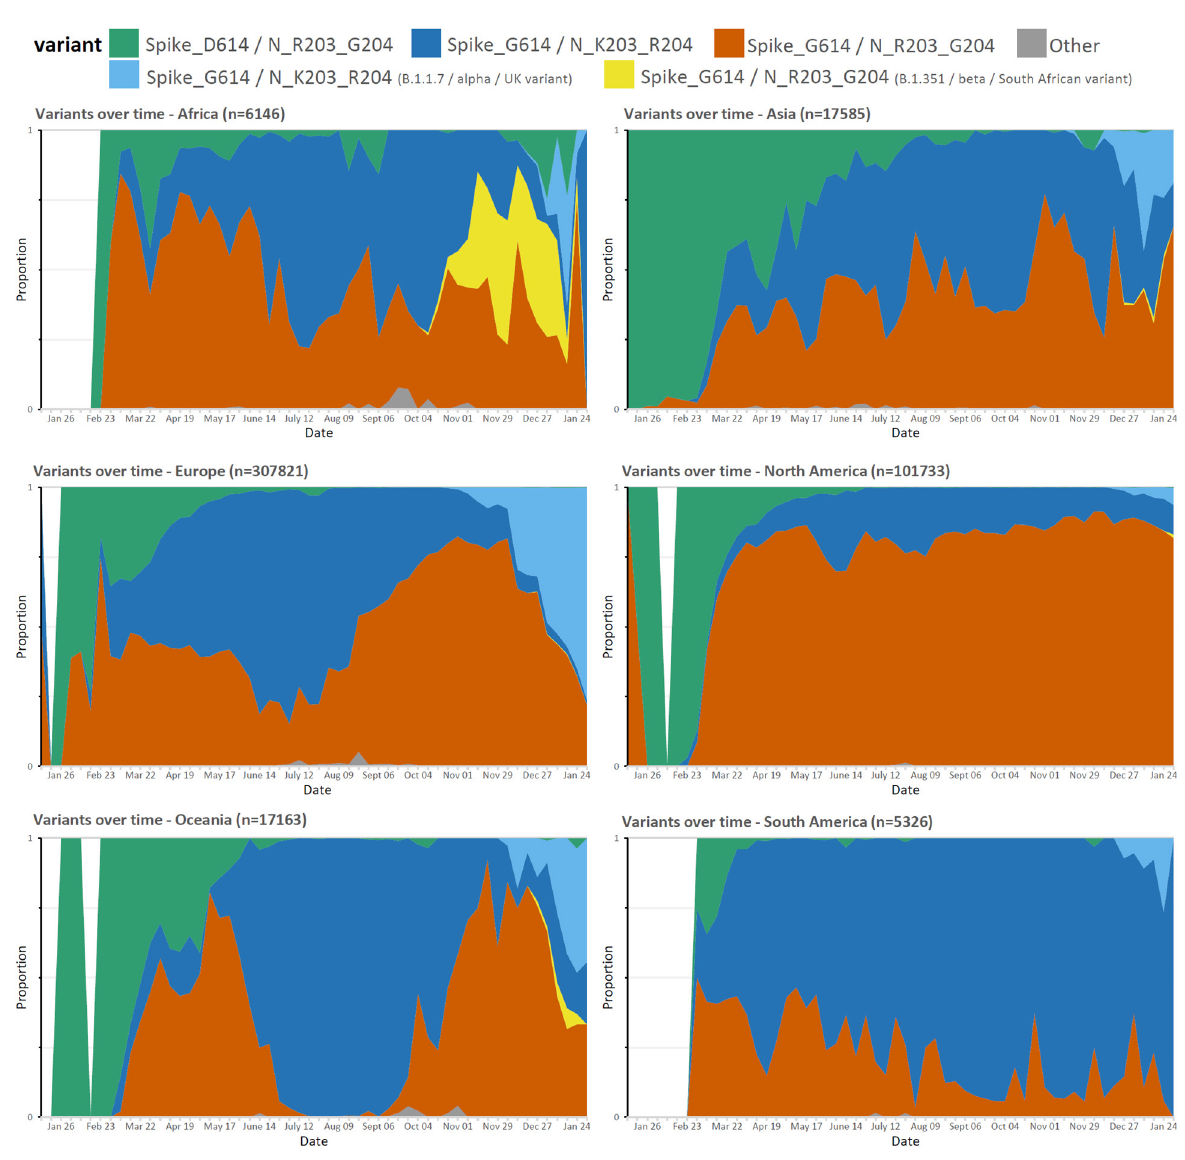
Figure 2. Proportion of weekly deposited SARS-CoV-2 sequences by region. The proportion of R203/ G204 to K203/R204 sub-variants of the D614G variant differs in different regions between January 2020 and January 2021 with recent increases in the frequency of new